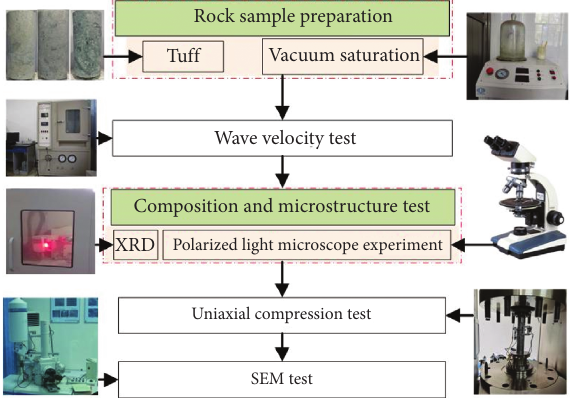
Figure 2: Experimental